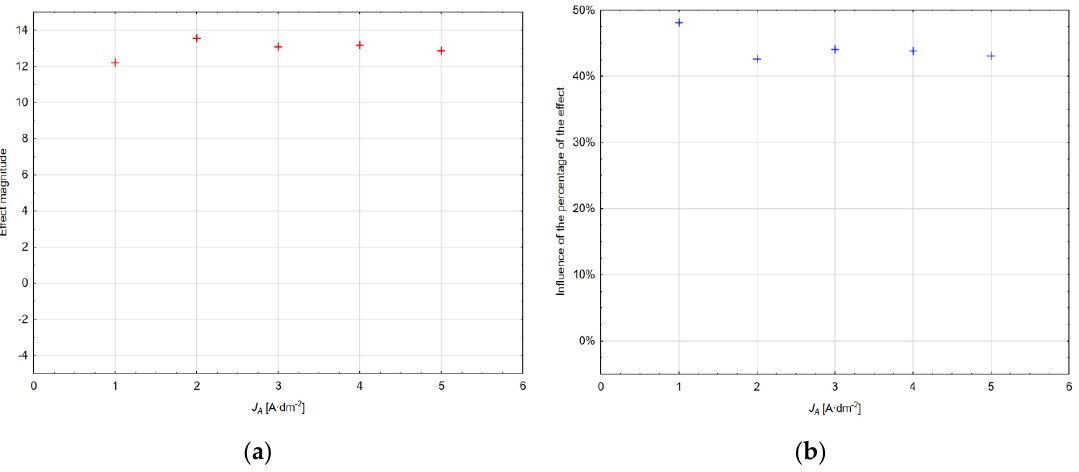
Figure 7. ( a ) The magnitude of the effect of the model absolute member for J A = 1 to 5 A·dm − 2 ; ( b ) The influence of the percentage of the model absolute member for J A = 1 to 5 A·dm − 2 .